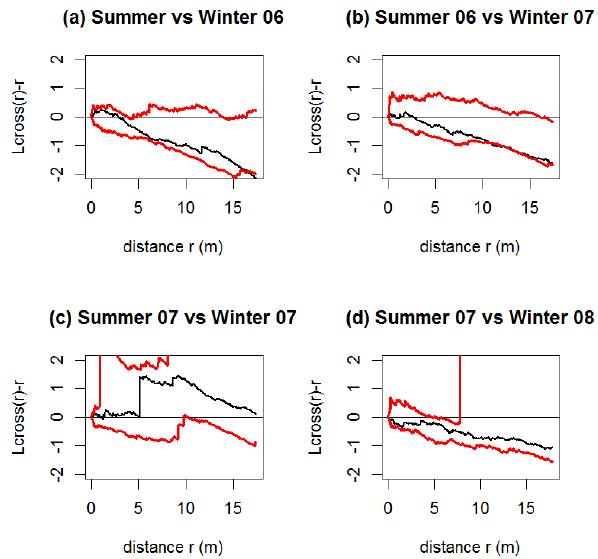
Figure 9. Cross-type L functions computed between subsequent epochs of measurement (black-coloured lines) considering the small erosion scars. The limits of significance envelope at level of 2% associated to “population independence” hypothesis are de- picted by red curves.